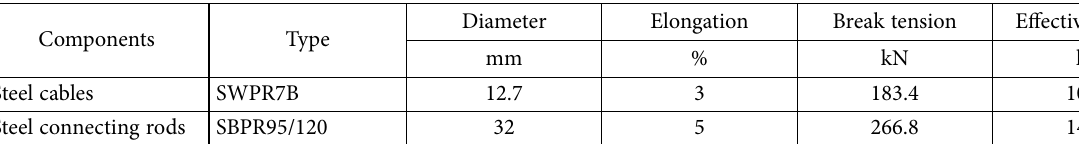
Table 1. Basic information of steel cables and steel connecting rods